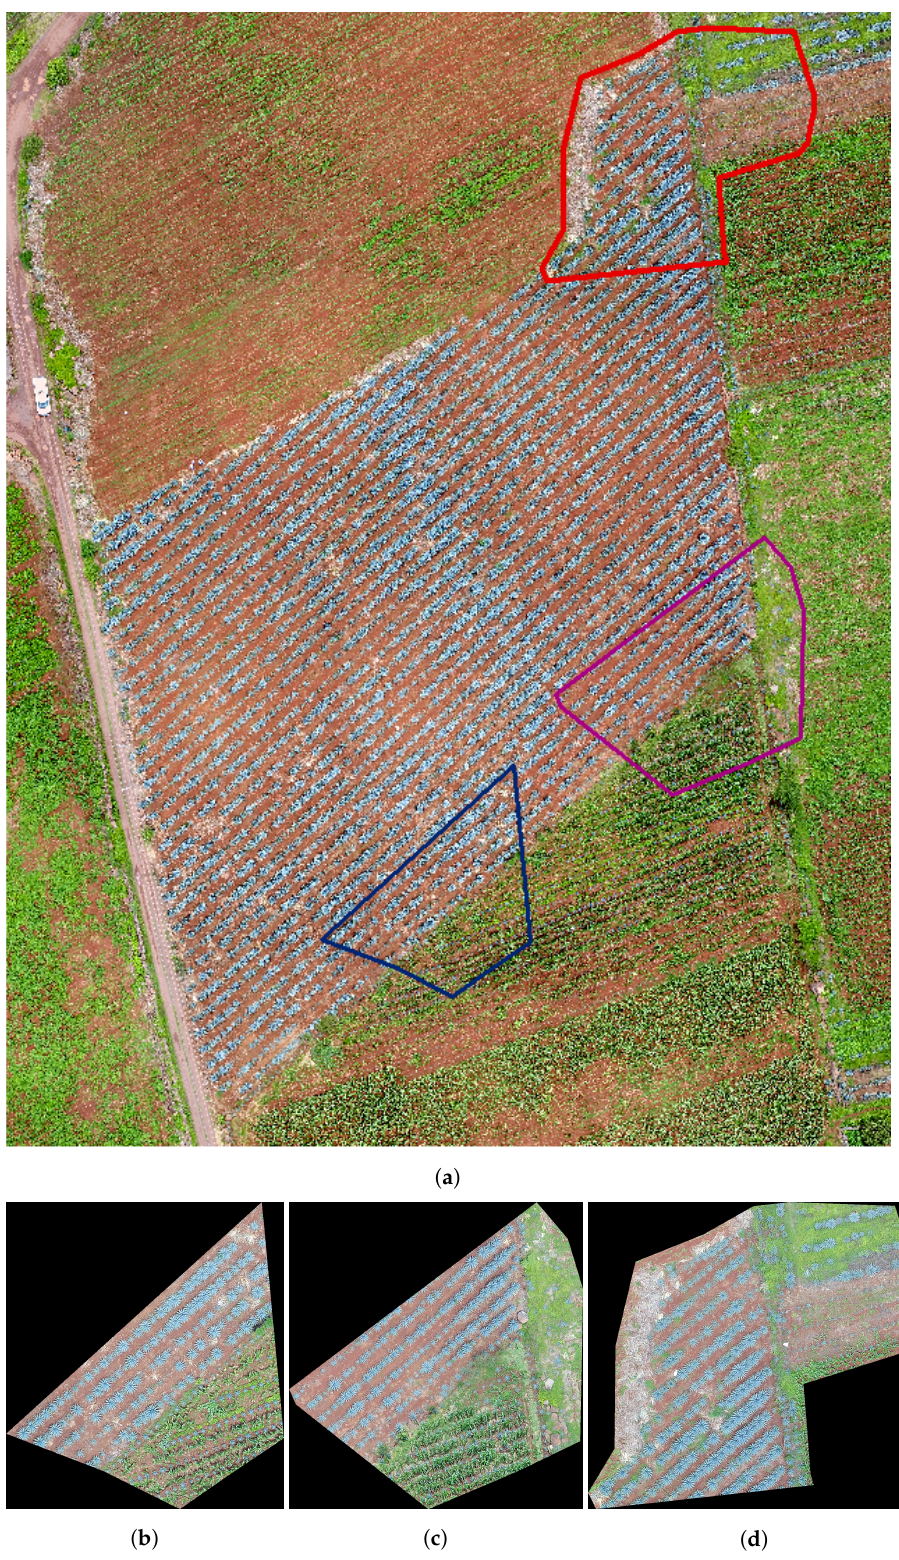
Figure 2. Images of Field 1 obtained with an Unmanned Aerial Vehicle (UAV): ( a ) Field 1 with some marked regions that are studied in this work, ( b ) the region in blue, ( c ) the region in purple, and ( d ) the region in